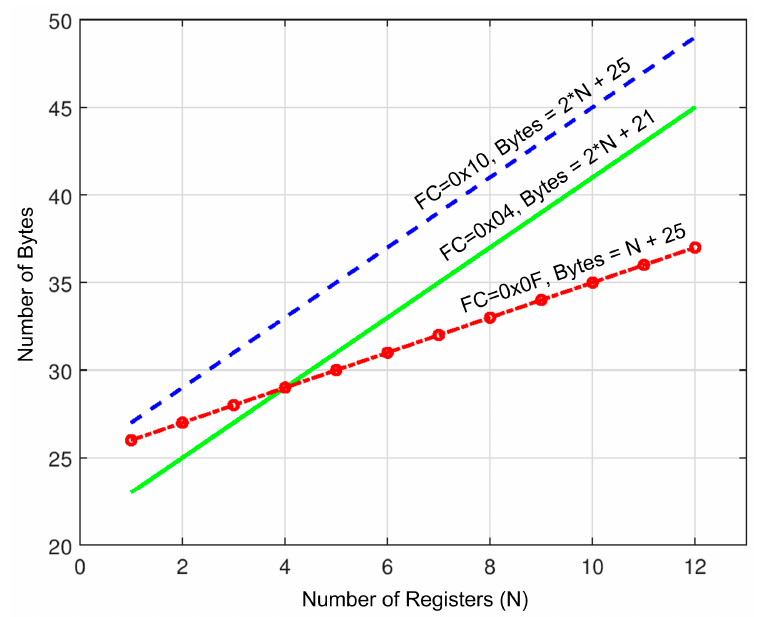
Figure 2. Relationship between the number of bytes and the number of registers of function codes (FC) “read input registers” (0x04), “write multiple coils” (0x0F), and “write multiple registers” (0x10).